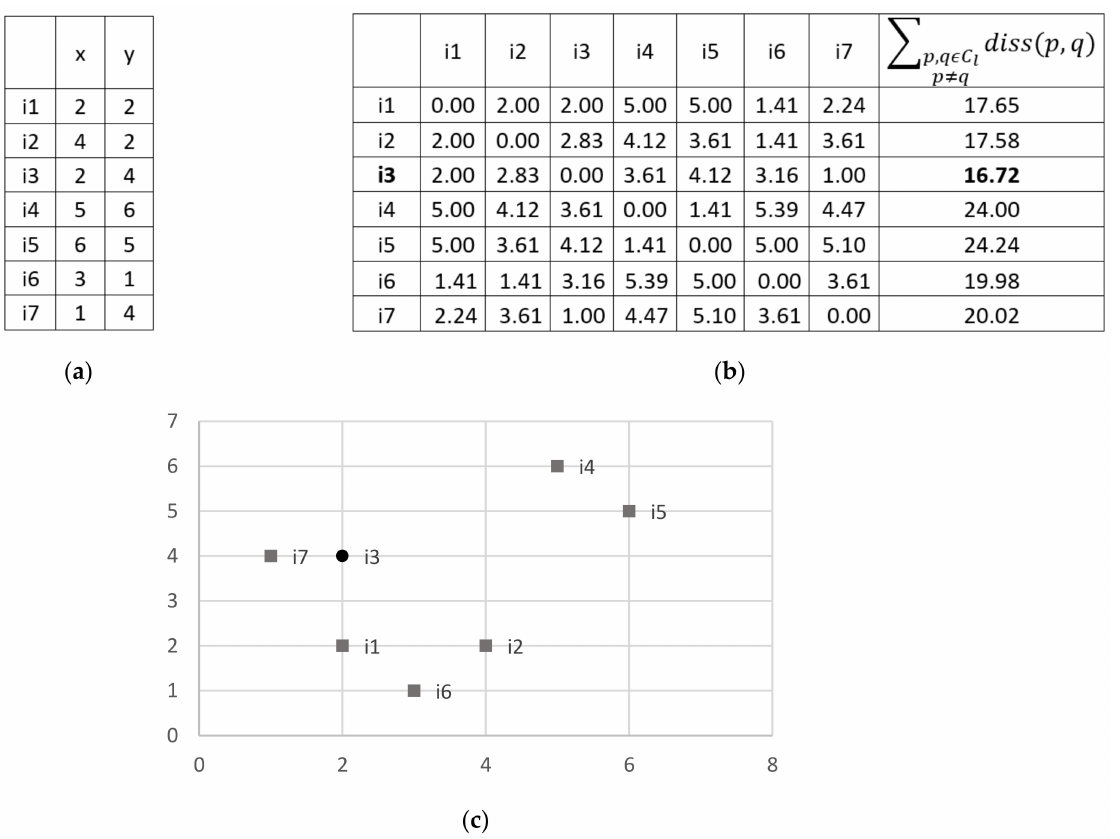
Figure 1. Example of computation of a cluster center with 2D instances. ( a ) Instances in the cluster ( b ), Total dissimilarity among instances (using in this case the Euclidean distance) and ( c ) Instances in 2D; the cluster center (instance having minimum overall dissimilarity) is highlighted by a